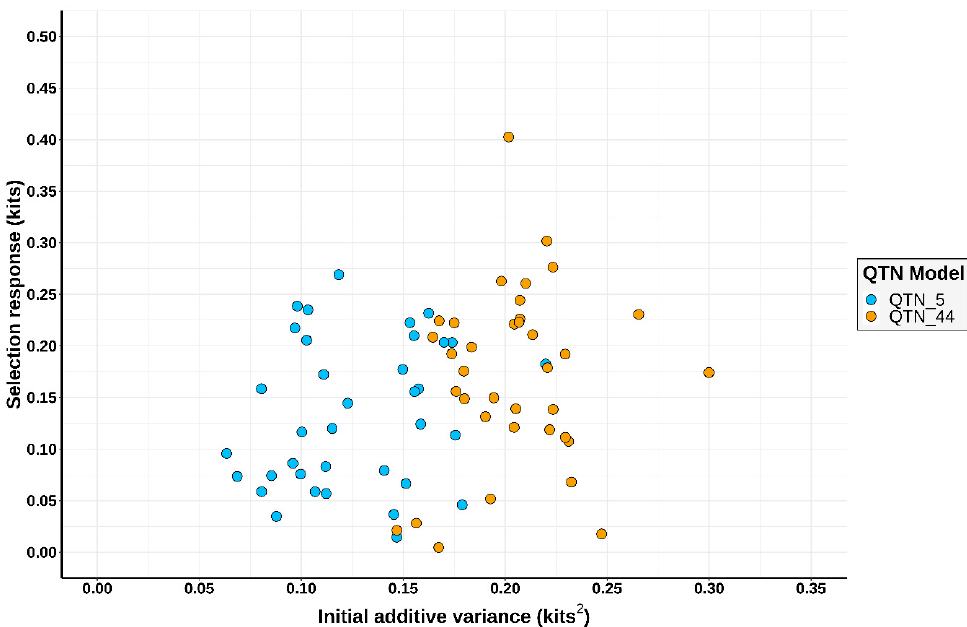
Figure 2. Relationship between initial additive variance and the response to genomic selection. The initial additive variance is the additive genetic variance at the 25th generation in which the genomic evaluations begin. QTN_5 stands for the QTN model with 5 QTNs per chromosome and QTN_44 stands for the QTN model with 44 QTNs per chromosome. The simulated rabbit genome comprised 20 chromosomes.